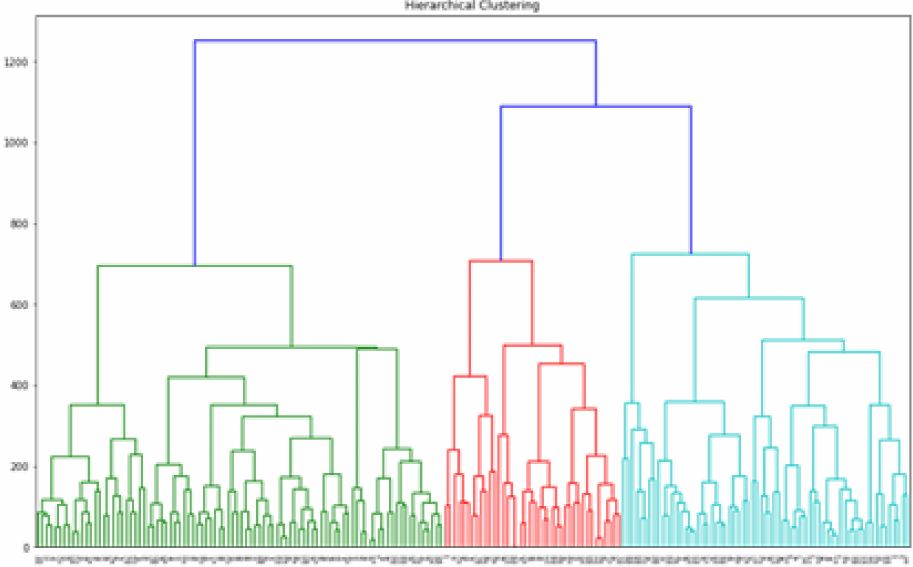
Figure A1. Agglomerative clustering (Euclidean,